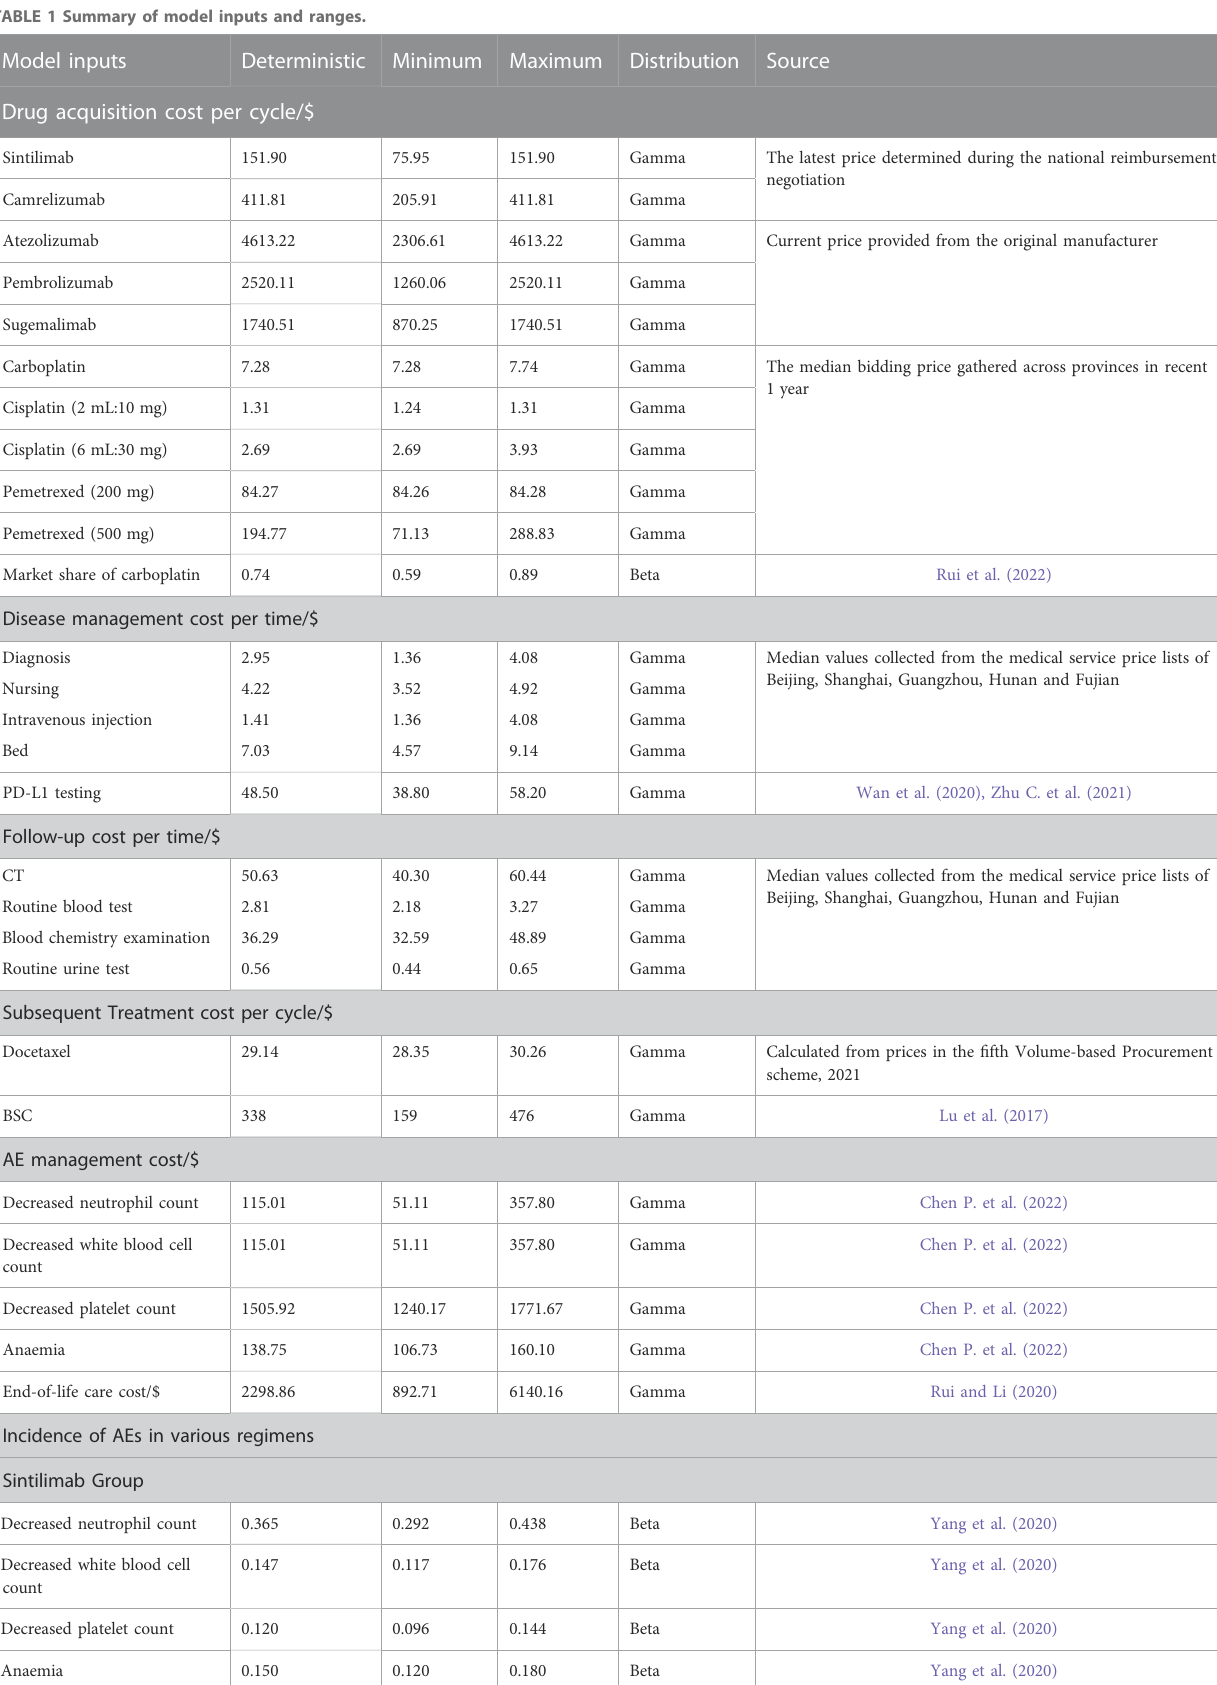
TABLE 1 Summary of model inputs and